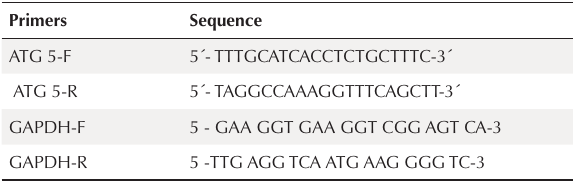
Table 1. The sequence of ATG-5 and GAPDH primers Primers